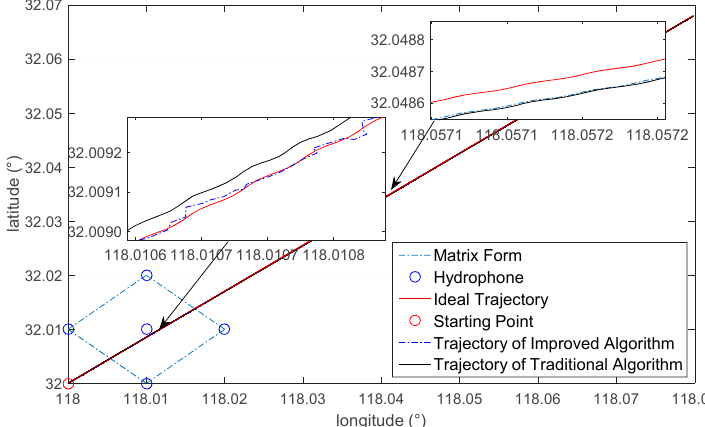
Figure 19. Dynamic simulation of the AUV integrated navigation system. Sensors 2016 , 16 , 42